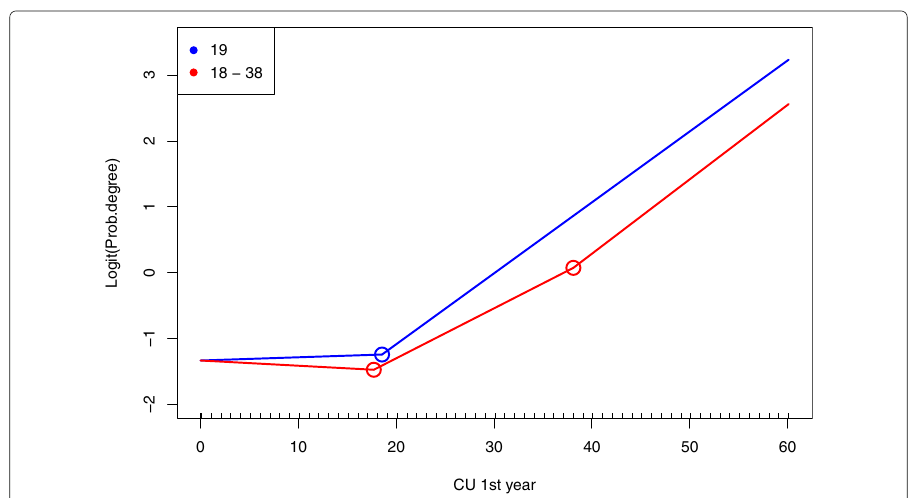
Fig. 3 Segmented relationship between the logit of the probability of success and CU of the marginal model in Eq. (4) for male (blue broken-line) and female (red broken-line) students. Cohort of freshmen enrolled in